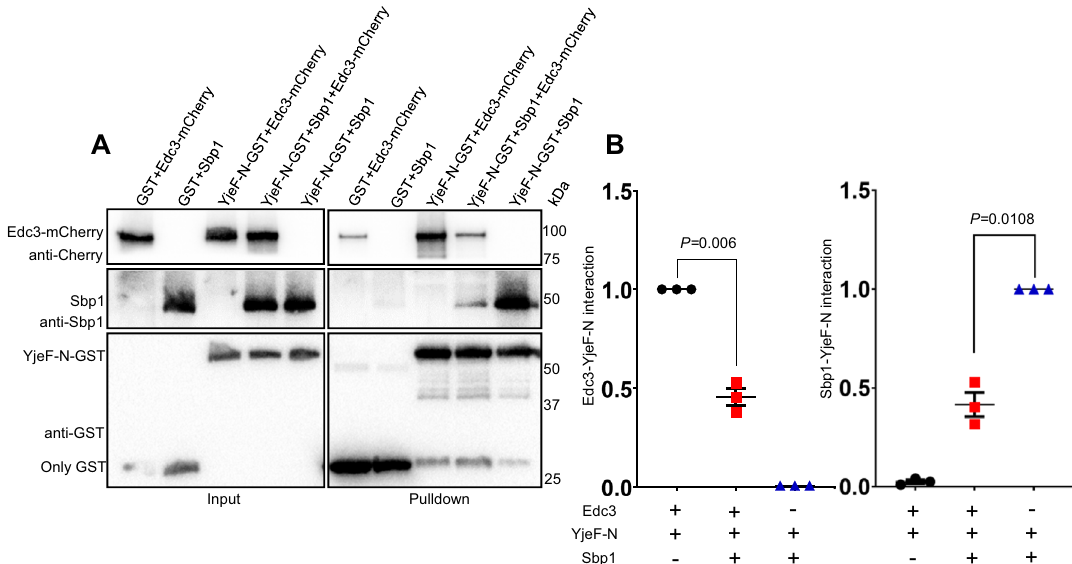
Fig. 6 Presence of Sbp1 leads to decreased Edc3-YjeF-N interaction. A Pull-downs followed by Western blot depicting competition between Sbp1-Edc3 interaction and Edc3 self-association. His-Sbp1-FLAG and Edc3-mCherry was puri fi ed using Ni-NTA chromatography. YjeF-N-GST fragment and only GST was puri fi ed with glutathione sepharose beads. Interaction studies using 100 pmol of each protein was carried out in 1X protein – protein interaction buffer (PPIB). See Materials and Methods section for details. B Quantitation of Western blot data presented in A . Left panel represents graph measuring Edc3- YjeF-N interactions whereas the panel on right represents the Sbp1-YjeF-N interactions. Data plots represent mean ± SEM from of n = 3, where ‘ n ’ represents number of independent experiments. A two-tailed paired student t -test was used to calculate P